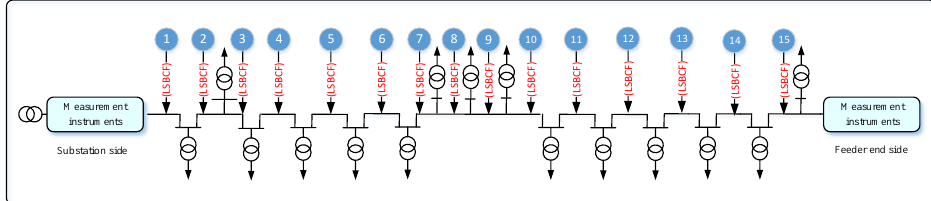
Figure 9. Implement the LSBC fault on the distribution feeder. Table 1. The parameters of the study